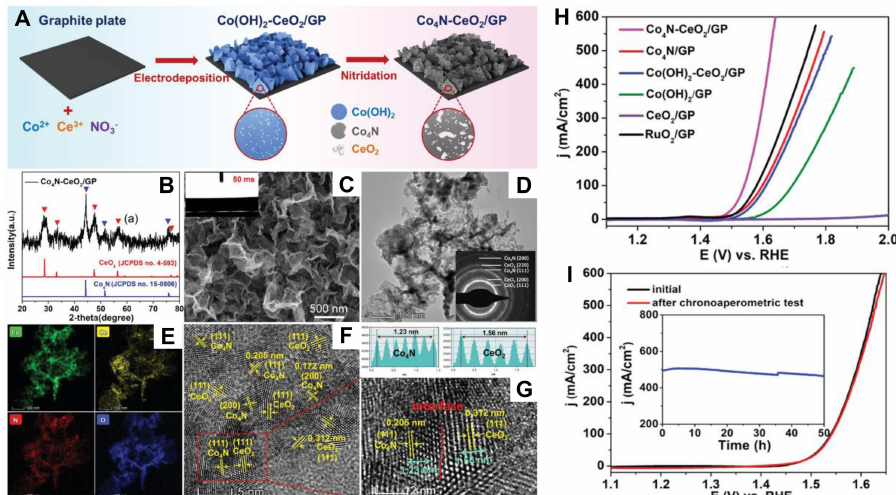
Figure 6. ( A ) Schematic of the formation of the Co 4 N-CeO 2 /GP; ( B ) XRD pattern of Co 4 N-CeO 2 /GP; ( C – G ) HRTEM image of CeO 2 , Co 4 N, and Co 4 N-CeO 2 /GP; ( H ) LSV curves of different electrocata- lysts in 0.1 M KOH electrolyte; ( I ) Potential cycling performance of Co 4 N-CeO 2 /GP. Reproduced with permission from [85]. Copyright © 2020 Wiley-VCH Verlag.